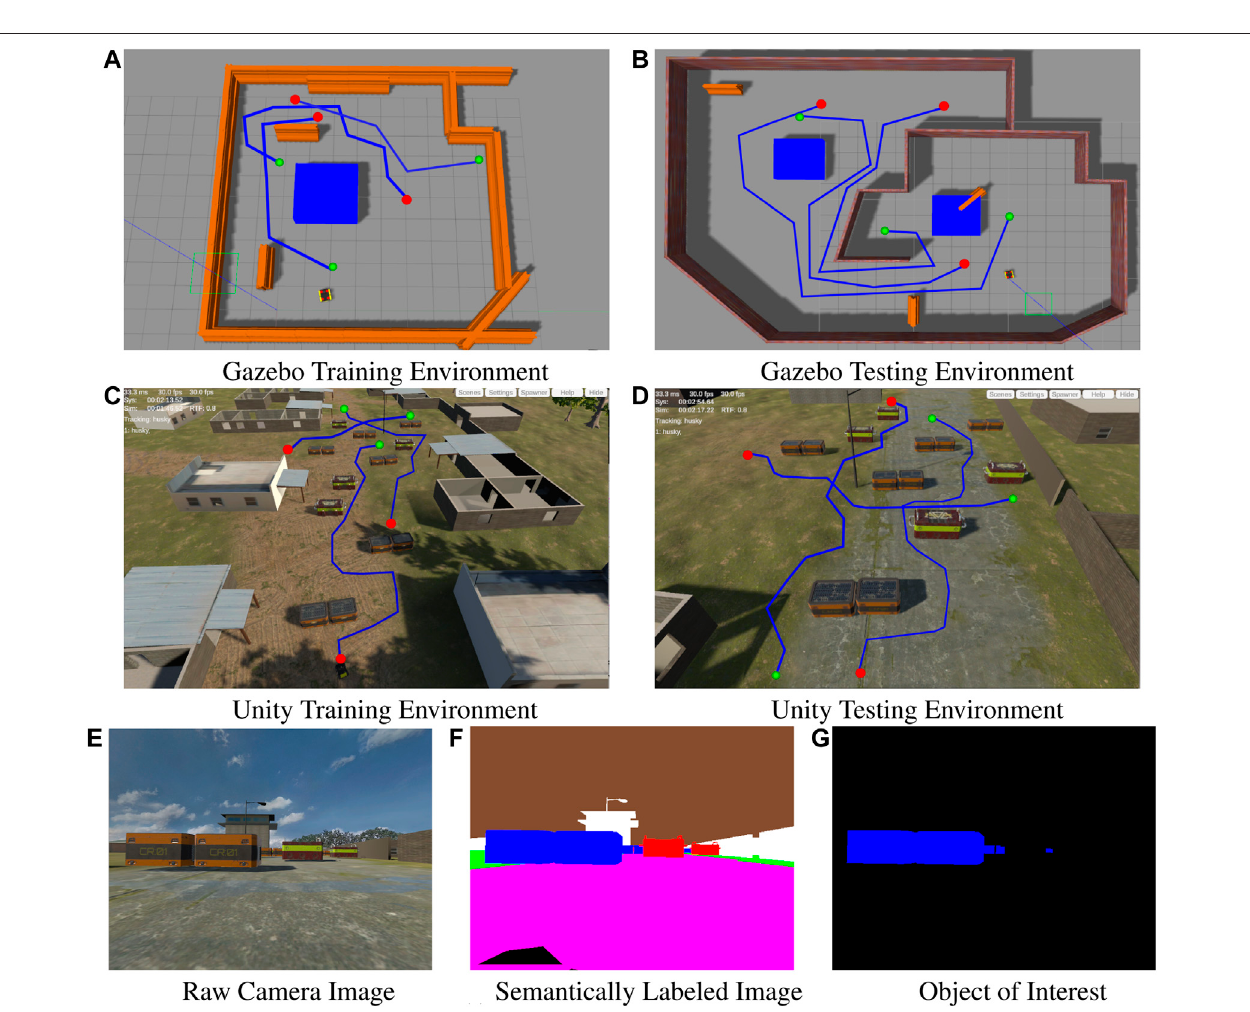
starting from the red dot to the goal location at the green dot. The bottom row of images displays the raw camera image (E) , the semantically segmented version of the raw image (F) and the object of interest extracted from the semantic image (G) used to generate the visual feature vector f C .